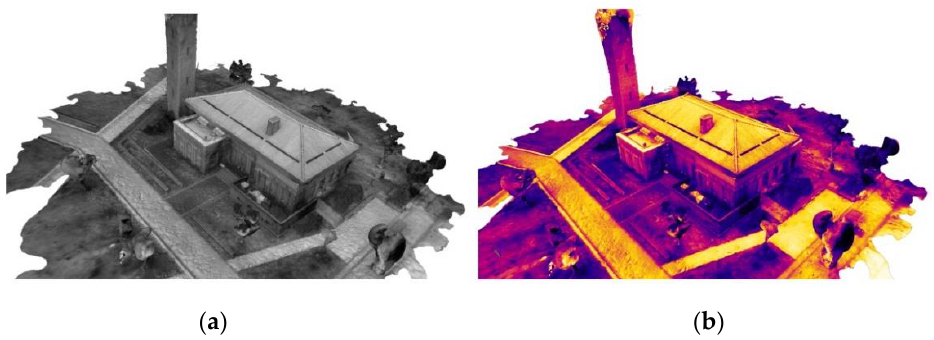
( c ) Figure 6. Images of ( a ) the flight plan, ( b ) the digital surface model (DSM), and ( c ) the digital orthophoto map (DOM).